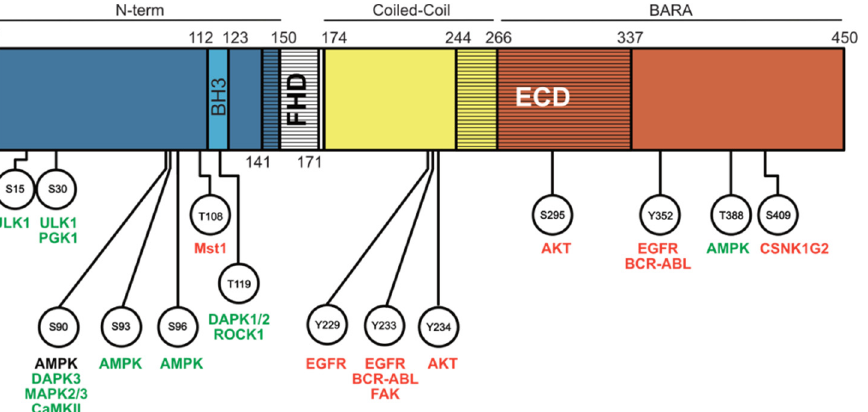
Figure 3. Phosphorylation events that regulate BECLIN1. Kinases that induce autophagy are indicated in green, and those with inhibitory effects are indicated in red. Black indicates a kinase/phosphorylation site of unclear effect on autophagy.